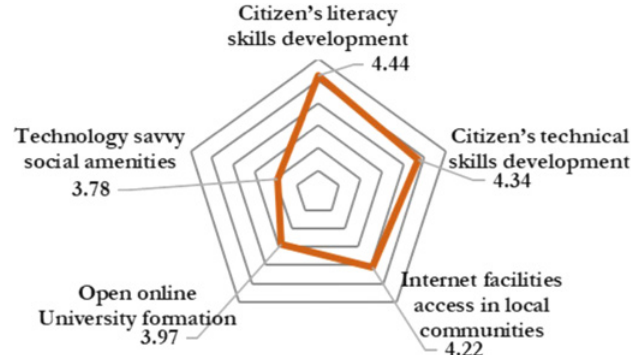
Figure 1 Influence of Education on Resilience.